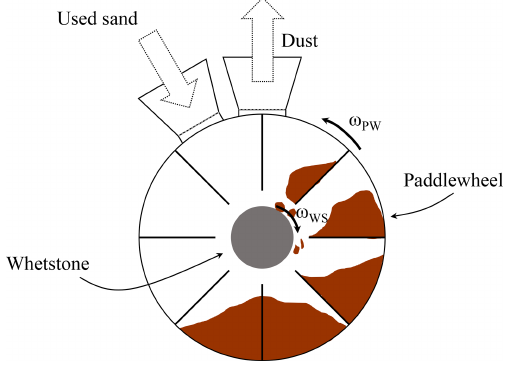
Figure 3. Mechanical regenerator according to Wijnker (2014). Such a regenerator was also used in our field